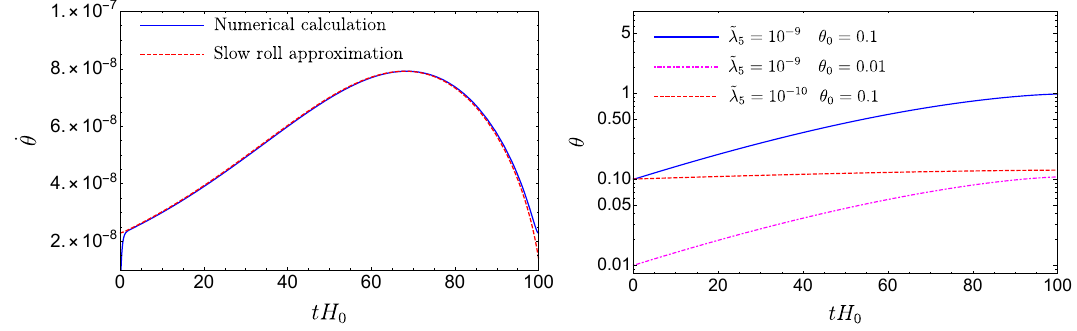
˙ Figure 2 . The dynamics of (left) θ and (right) θ during inflation are depicted, in Planck units. The left figure provides a comparison of the exact numerical result with the analytical result found in eq. (4.6) for ˜ λ = 10 − 9 . The other input parameters selected are ξ = 300 and λ = 4 . 5 · 10 − 5 , 5 with the following initial conditions χ = 6 . 0 M , ˙ χ = 0 , and ˙ θ = 0 used. We choose ˜ µ to be 0 p 0 0 sufficiently small to not affect the dynamics, and where we define H = m 2 0 S /